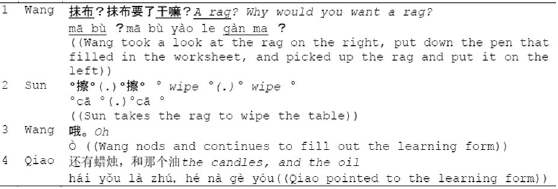
At turn 2, Wang responds loudly to the blue cloth